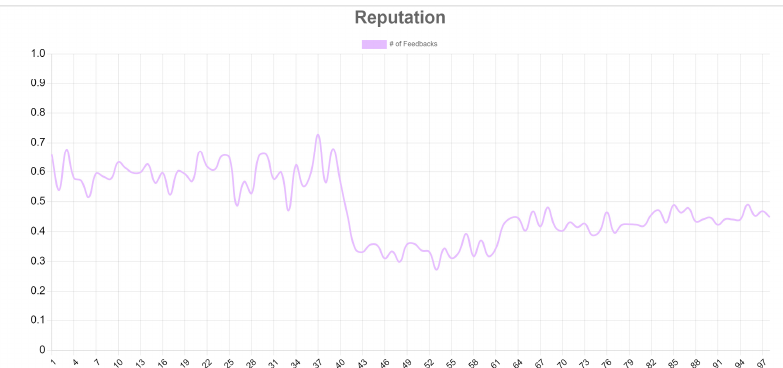
Figure 4. Reputation Chart for SP1.